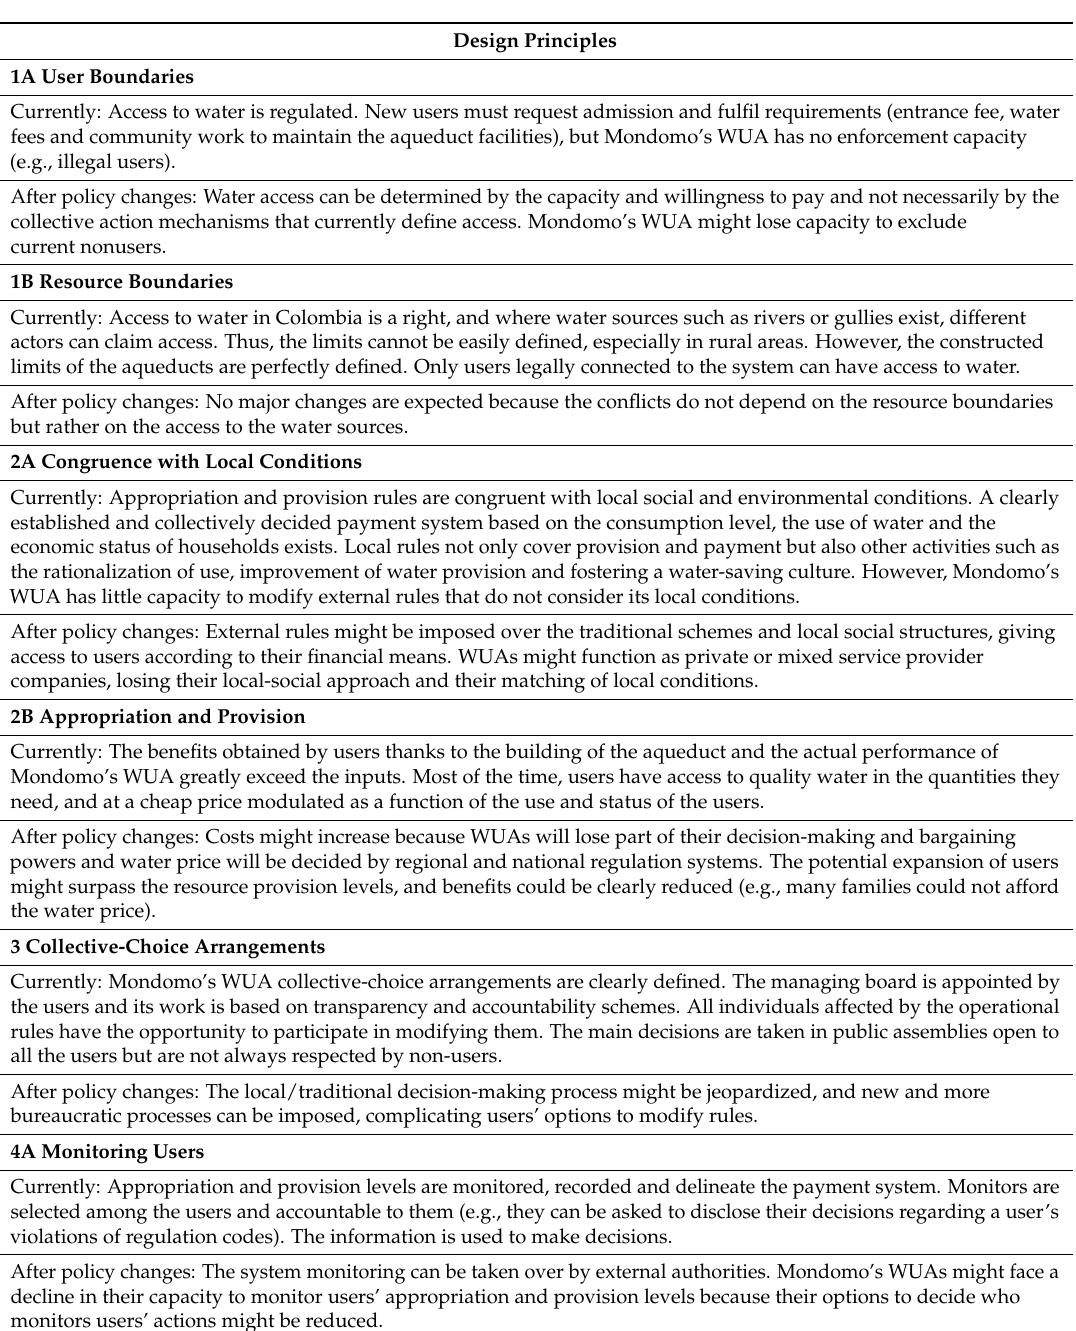
Table 3. DP scores according to the fuzzy membership